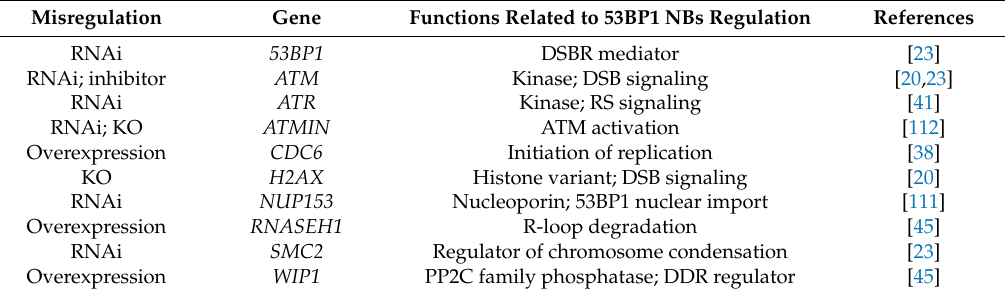
Table 2. Genes involved in the decrease of 53BP1 NBs formation when